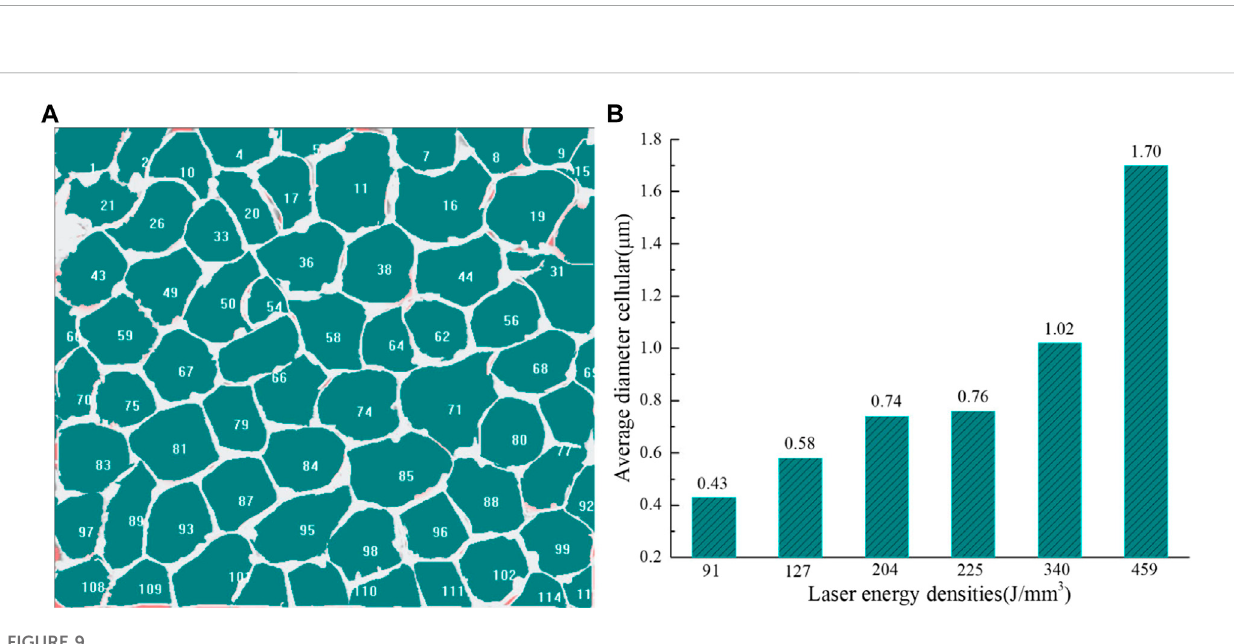
FIGURE 9 (A) The statistical diagram of cellular size under LED of 255 J/mm 3 and (B) the average cellular sizes at different